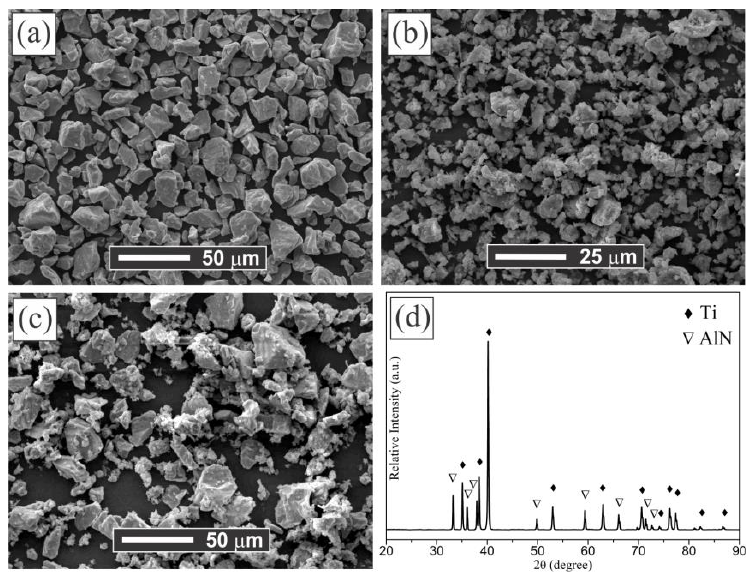
Figure 1. ( a ) and ( b ) SEM images for the Ti and AlN as-received powders, respectively; ( c ) and ( d ) SEM image and XRD of the Ti:AlN powder mixture,